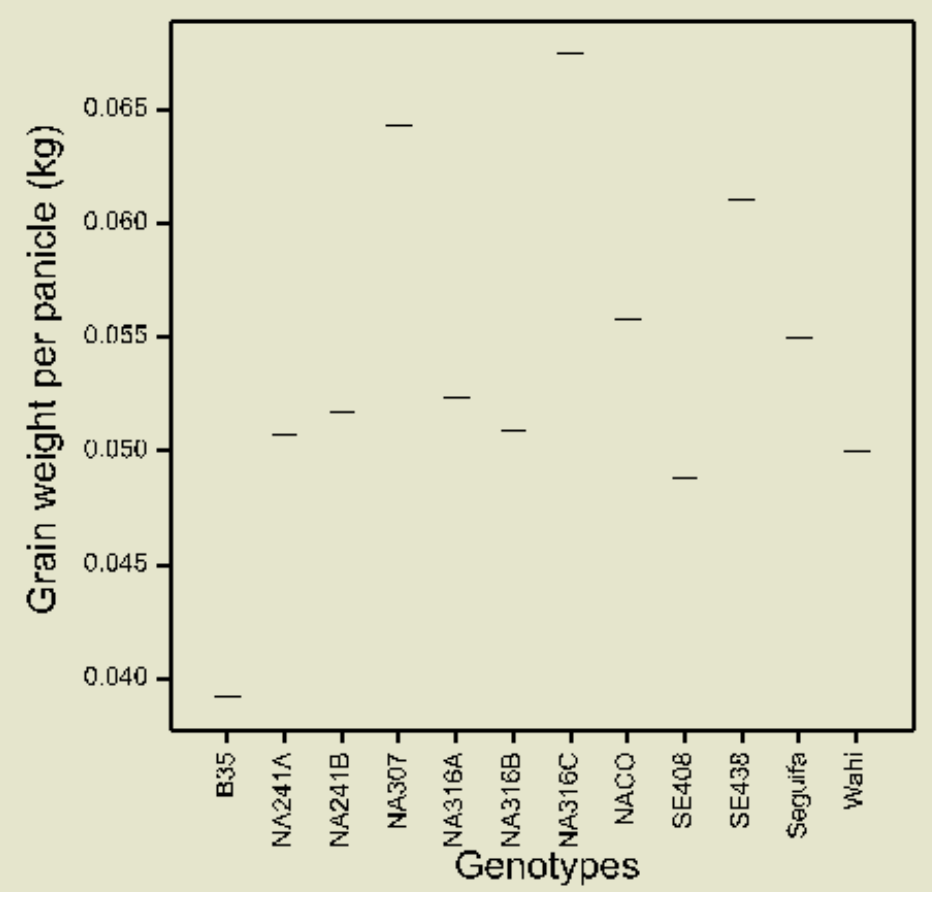
Figure 1. Boxplot of mean grain weight per panicle of BC 2 F 3 genotypes and parents across well ‐ watered and water ‐ stressed environments.